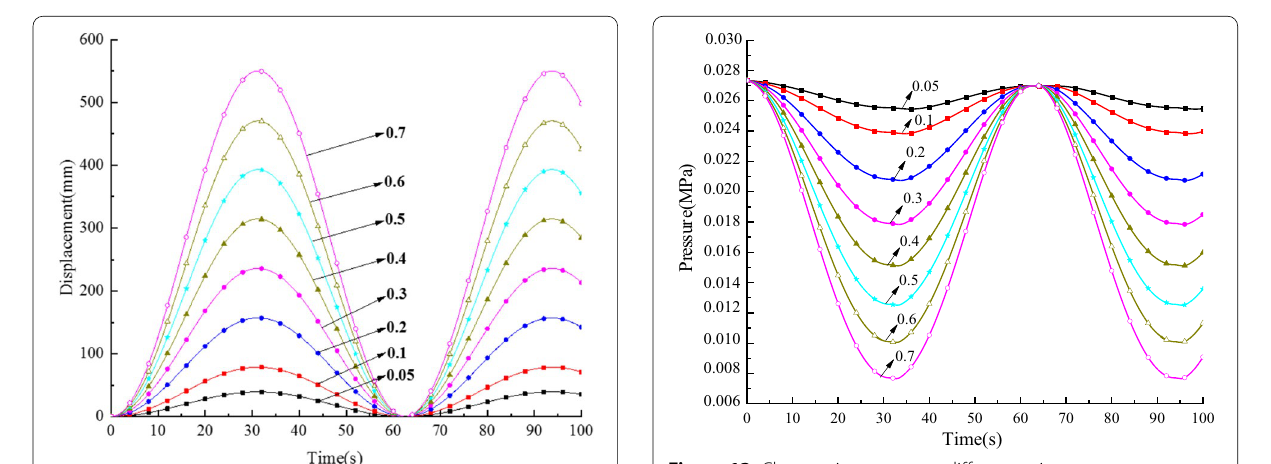
Figure 13 Changes in pressure at different